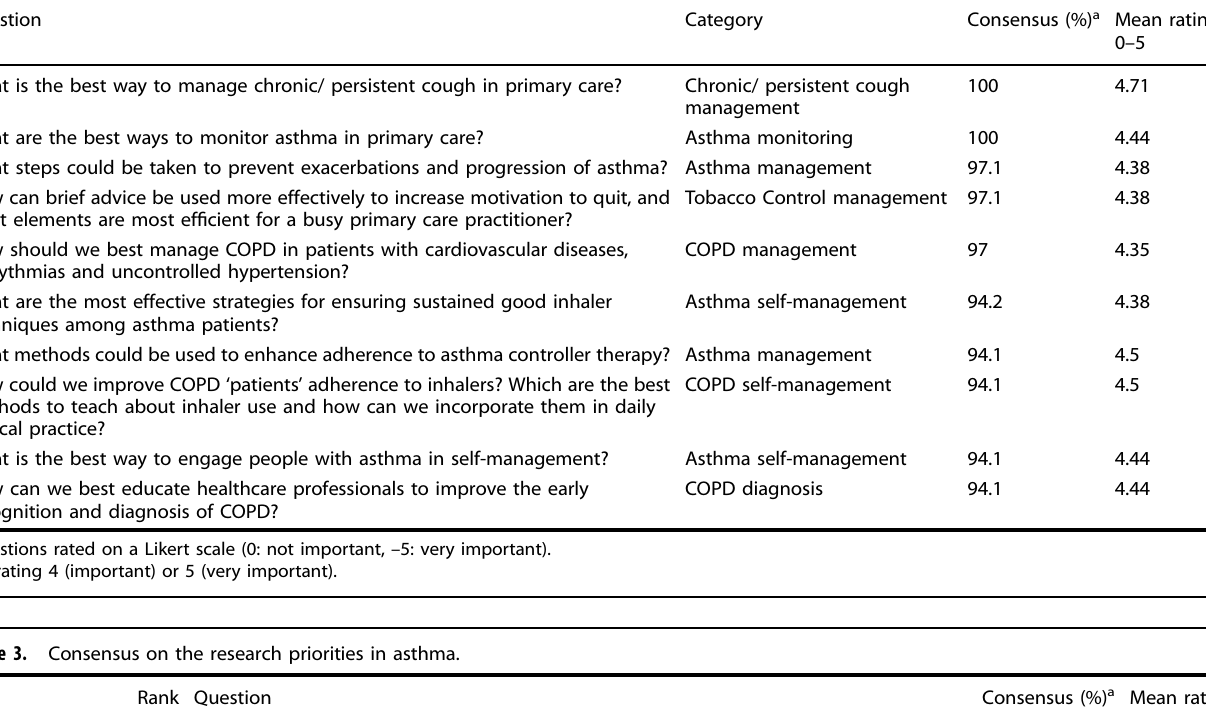
Table 2. Top 10 primary care research respiratory